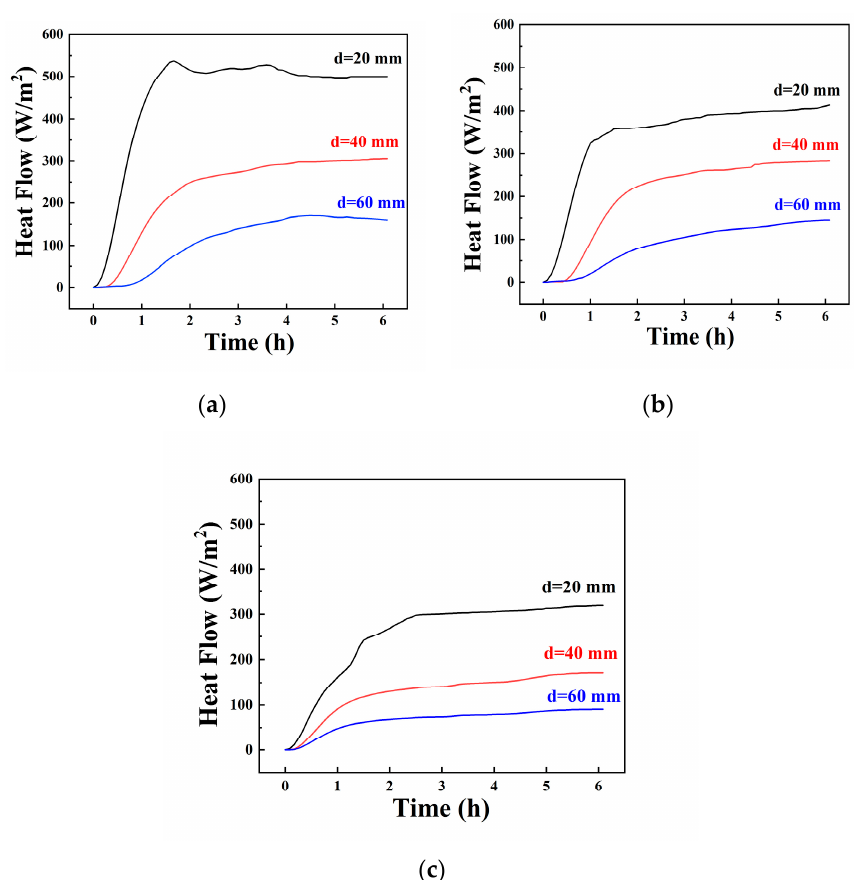
Figure 9. The heat flux variations of samples at different distances d between the heat source and sensors: ( a ) samples A#, ( b ) samples B#, ( c ) samples C#.